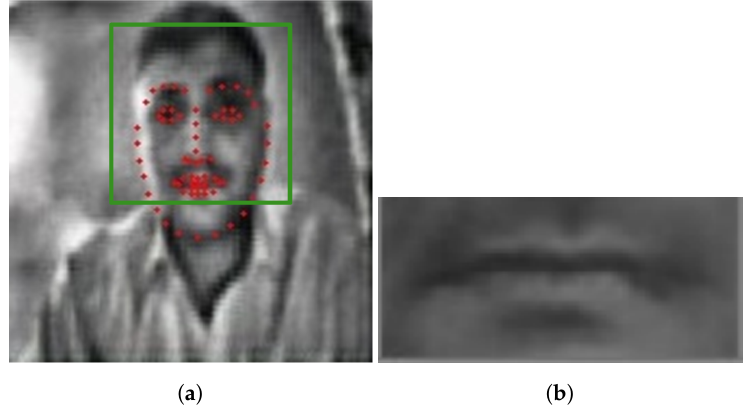
Figure 8. ( a ) Landmarks identification on frontal faces, ( b ) mouth